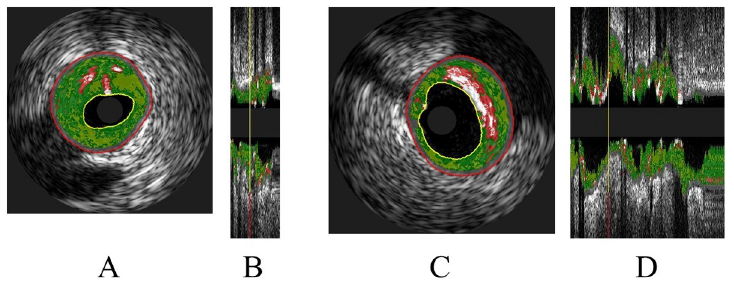
Fig 1. Representative virtual-histology intravascular ultrasound images. A . A cross-sectional image of the lesion in a patient in the low apolipoprotein B (LAB) group. The composition of the entire lesion by volume percentage is fibrous (green), 54.43%; fibrofatty (light green), 29.09%; necrotic core (red), 12.96%; and dense calcium (white), 3.52% B . Longitudinal section of the lesion in the same patient in the LAB group. The yellow line indicates the location of the cross-section shown in (A). C . A cross-sectional image of the lesion in a patient in the high apolipoprotein B (HAB) group. The composition of the entire lesion by volume percentages are as follows: fibrous (green), 48.99%; fibrofatty (light green), 20.24%; necrotic core (red), 22.36%; and dense calcium (white), 8.41%. D . Longitudinal section of the lesion in the same patient in the HAB group. The yellow line indicates the location of the cross-section shown in (C).